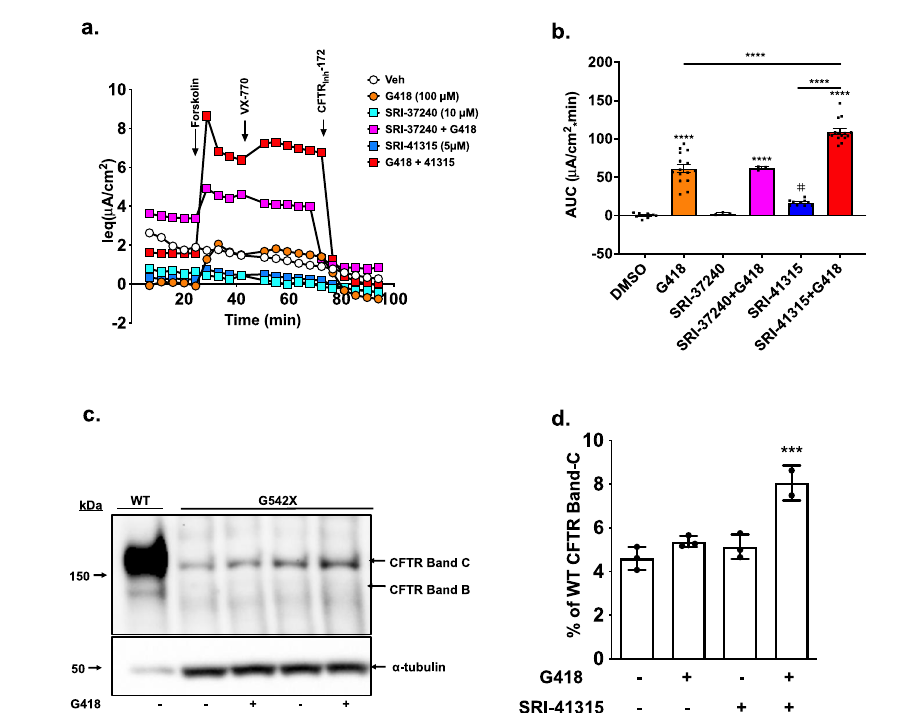
Fig. 5 Combining G418 with SRI-41315 enhanced CFTR expression and function in CFTR -G542X 16HBEge cells. CFTR -G542X 16HBEge cells were treated with SRI-37240 (10 µ M) or SRI-41315 (5 µ M) alone and in combination with G418 (100 µ M) for 72 h. CFTR-speci fi c channel activity in treated cells